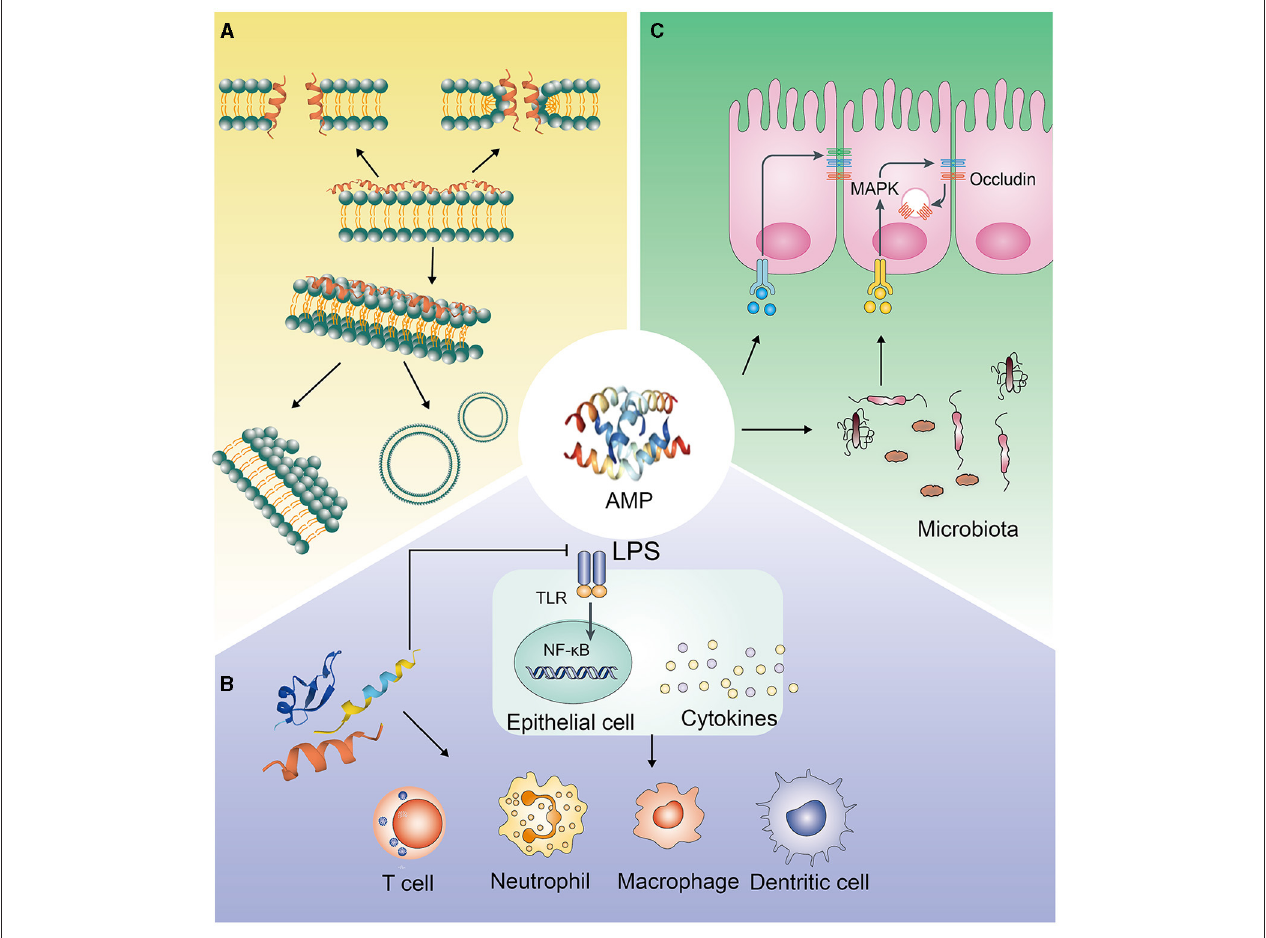
FIGURE 1 | Antimicrobial pathways of AMPs. (A) Interacting with pathogenic bacteria directly; (B) Eliminating pathogenic bacteria through immune regulation; (C) Inhibiting the invasion of pathogenic bacteria by regulating the intestinal